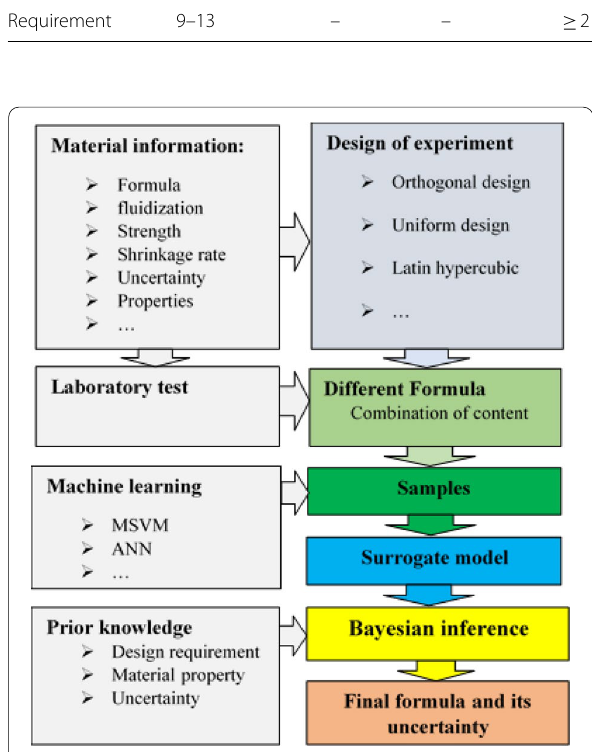
Fig. 5 Flowchart of the developed